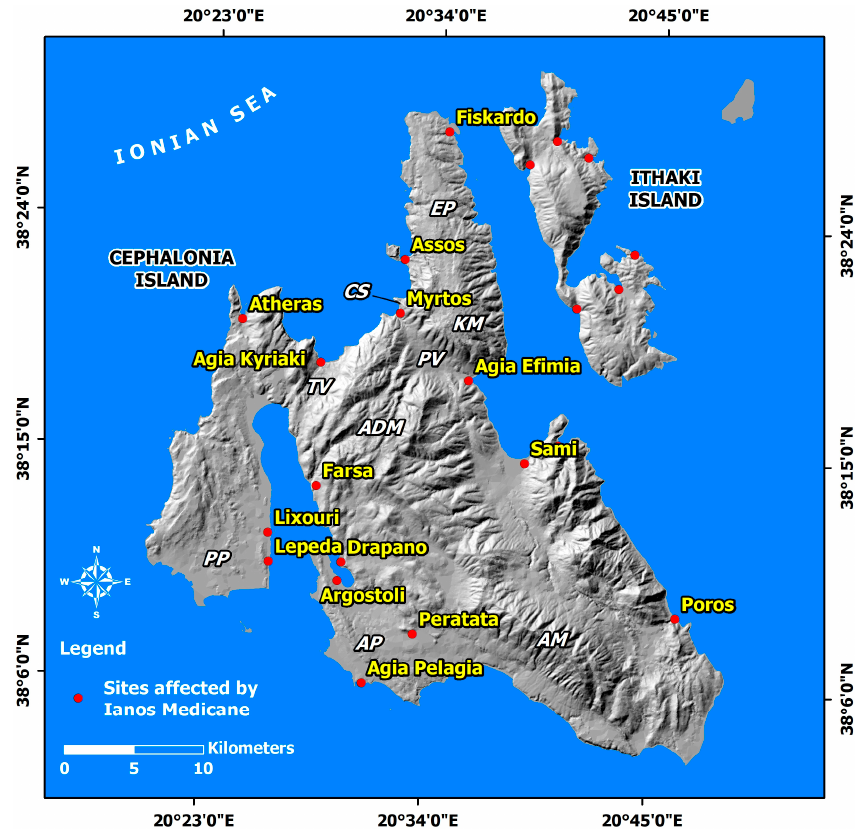
Figure 4. Spatial distribution of sites affected by Medicane Ianos in Cephalonia Island. EP : Erissos Peninsula; CS : Charakas site; KM : Kalon Mt; PV : Pylaros valley; TV : Thinia Valley; ADM : Agia Dynati Mt; AM : Aenos Mt; AP : Argostoli peninsula. The study area of Myrtos is located at the western end of Pylaros valley corresponding to the transition zone from the Erissos peninsula to the moun ‐ tainous central Cephalonia.